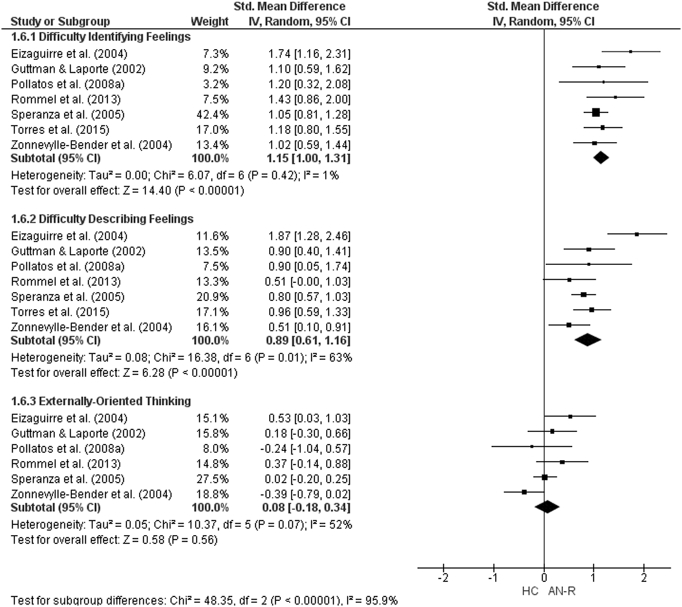
Forest plot of mean TAS subscale scores: standardized mean effect size for differences (SMD) between Anorexia Nervosa, Restricting subtype (AN-R) and Healthy Controls (HC). CI, confidence interval.